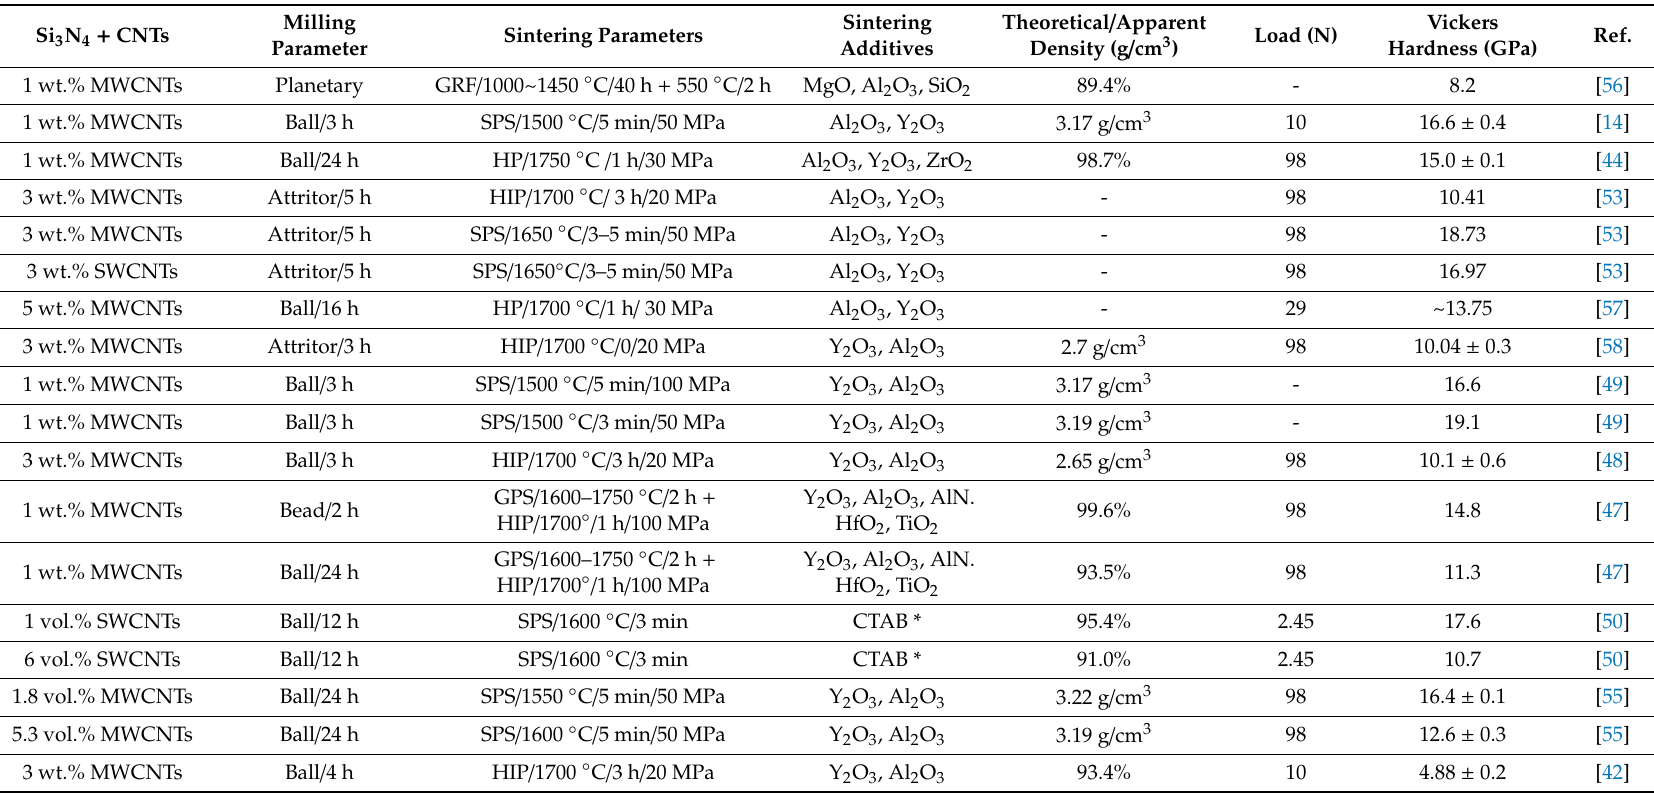
Table 2. Vickers hardness of CNT-reinforced silicon nitride composites reported in the literature measured using di ff erent applied